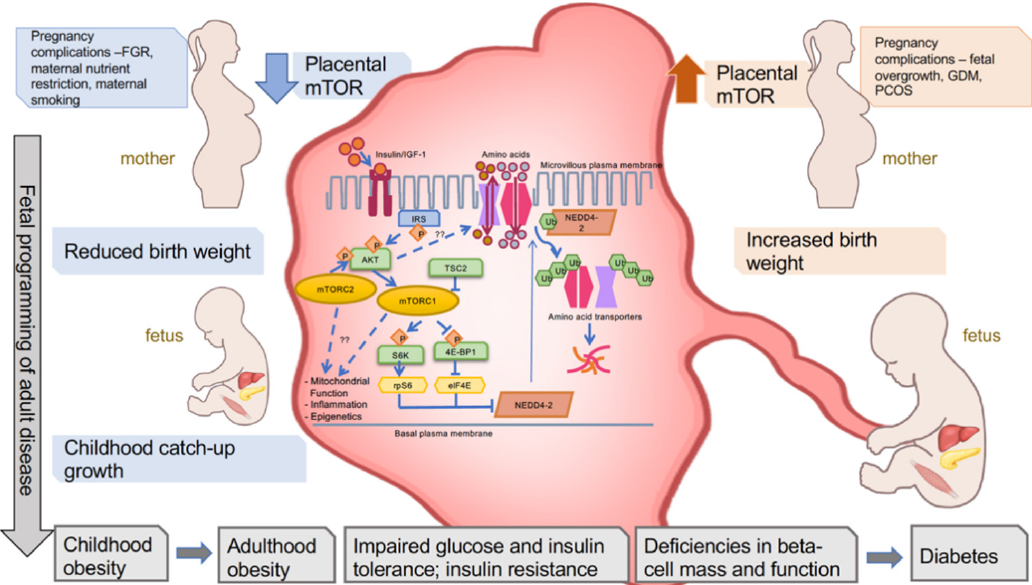
Figure 1. Placental mTOR signaling is altered during pregnancy complications and is associated with birth weight and metabolic health trajectory of the offspring. Various complications during pregnancy lead to decreased mTOR signaling or increased mTOR signaling in the placenta. Upstream regulators and downstream targets of mTOR signaling are depicted, including well-known (solid arrow) and proposed (dashed arrow) players. Decreased placental mTOR signaling and amino acid transport are associated with reduced birth weight and subsequent childhood catch-up growth. Increased placental mTOR signaling and nutrient transport are associated with increased birth weight. There is a positive relationship between both reduced and increased birth weight and childhood obesity, followed by metabolic dysfunction and diabetes in adulthood.